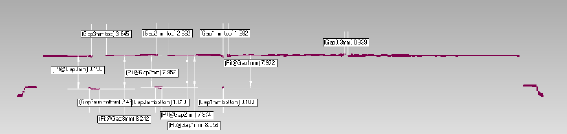
Figure 15. Team4: A good detection of gaps from 3mm to 1mm can be shown. This figure shows the numeric evaluation of the gaps and pits.